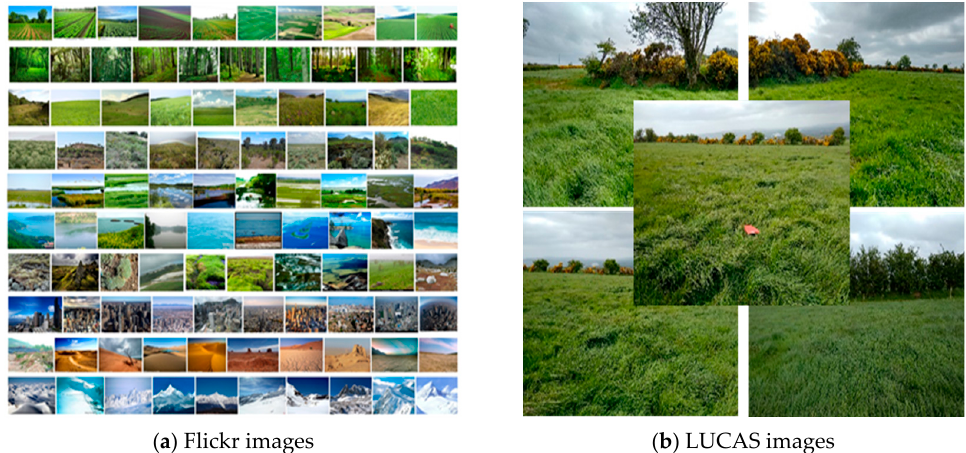
Figure 3. Part of natural scene image datasets. ( a ) Flickr images; ( b ) LUCAS images to the north, south, east, west and